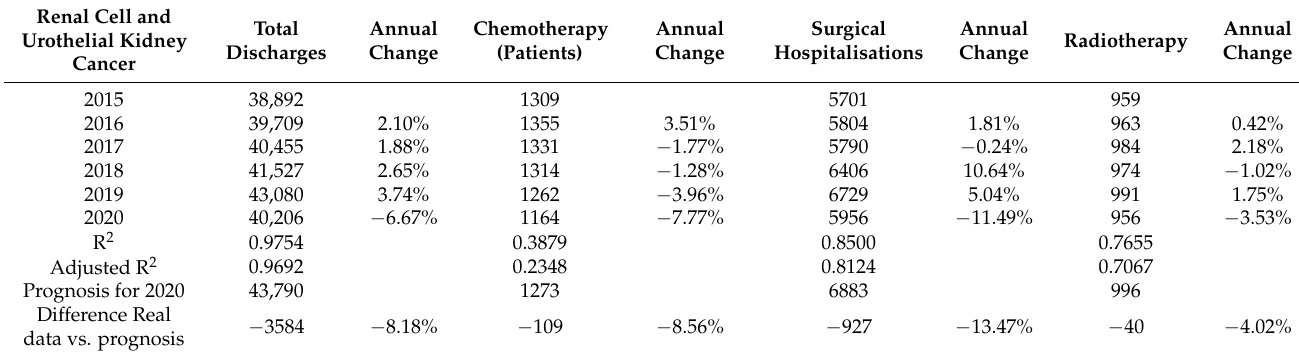
Table 6. Renal cell and urothelial kidney cancer hospitalisations.